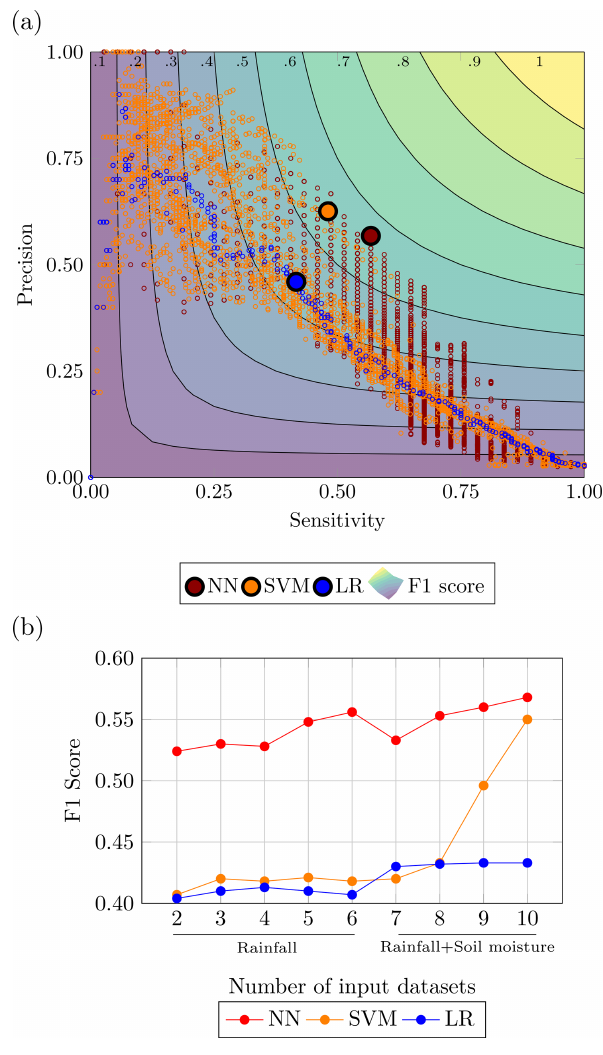
Figure 9. Performance evaluation for the flood case: (a) perfor- mances of the top 1% configurations in the precision-sensitivity space highlighting the highest F1 score and (b) comparison of ML methods with LR with combination using increasing number of in- put